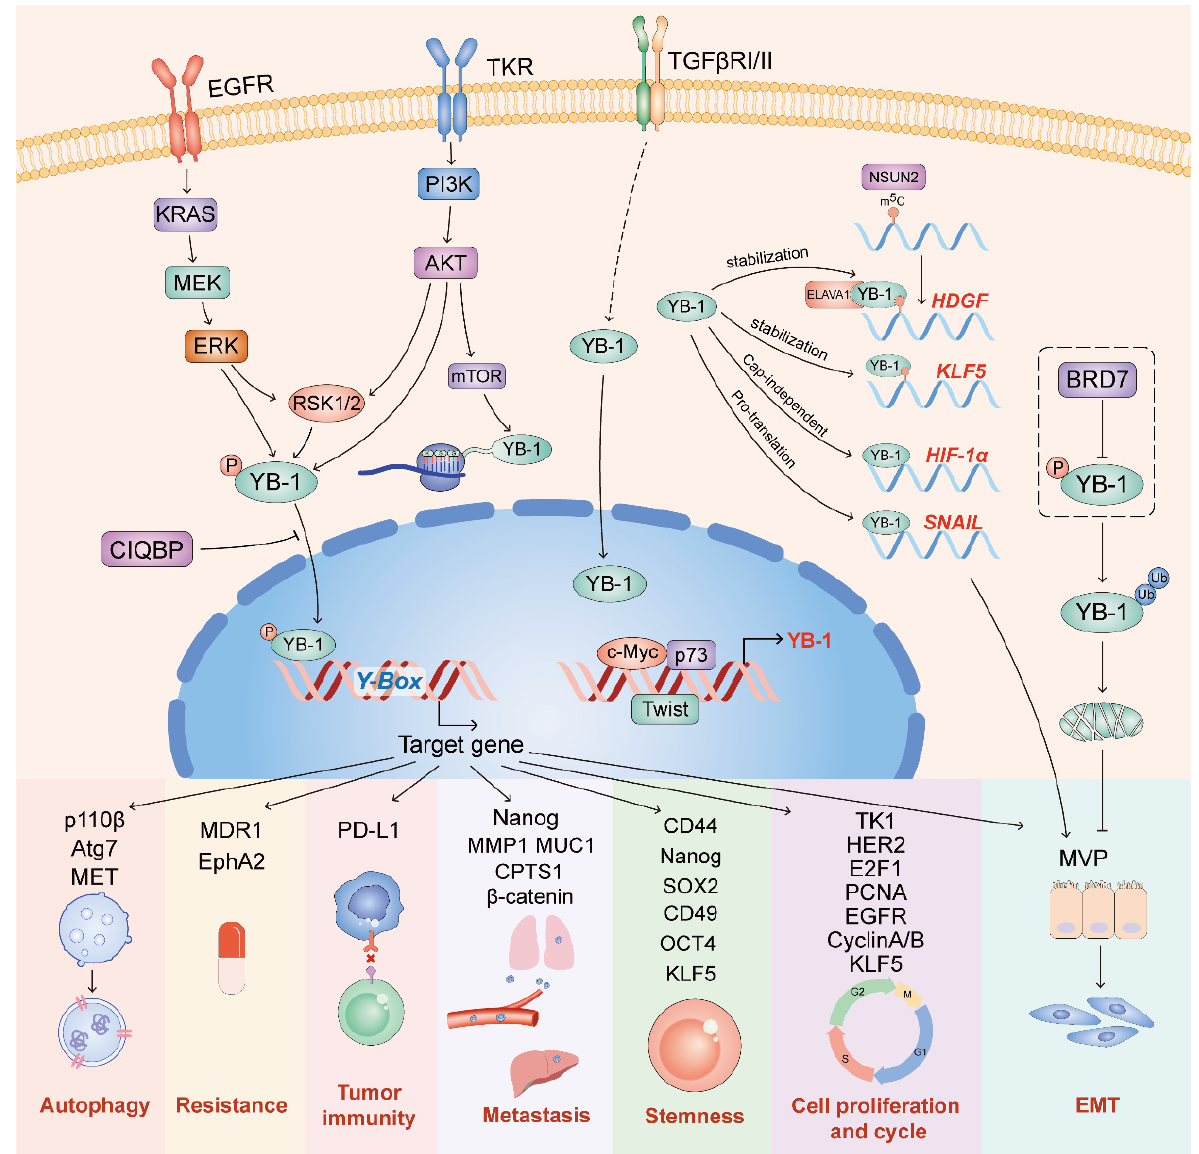
Figure 2. YB-1 is involved in multiple oncogenic signaling pathways. These pathways include PI3K/AKT, Ras/MEK, and TGF- β . YB-1 is phosphorylated by AKT, ERK, and RSK-2 into the nucleus to regulate the expression of target genes.